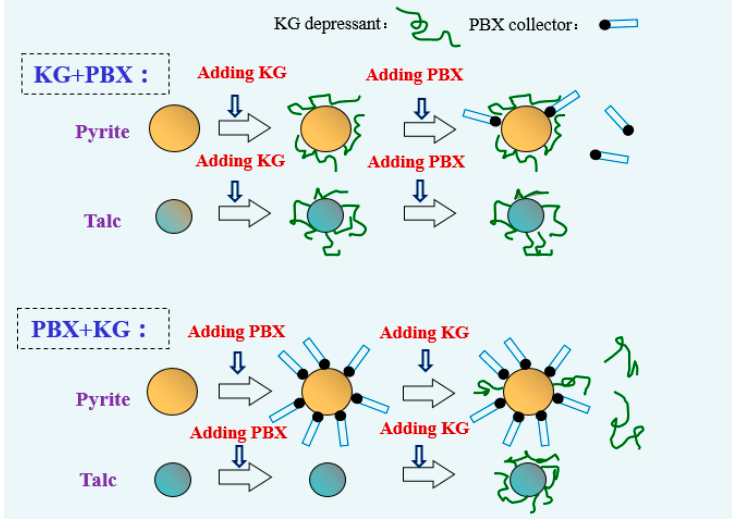
Figure 11. Schematic illustration of the addition order of KG/PBX that affects the reagent Figure adsorption order.